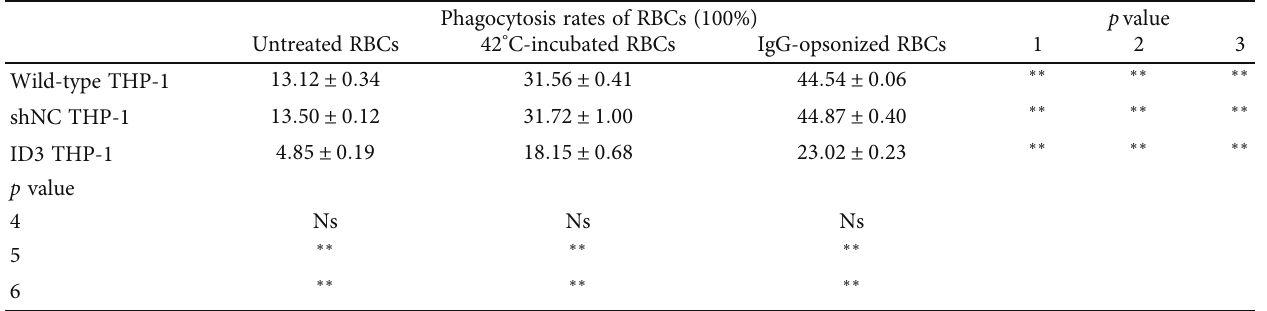
Table 1: Results of THP-1 cells engulfed RBCs.